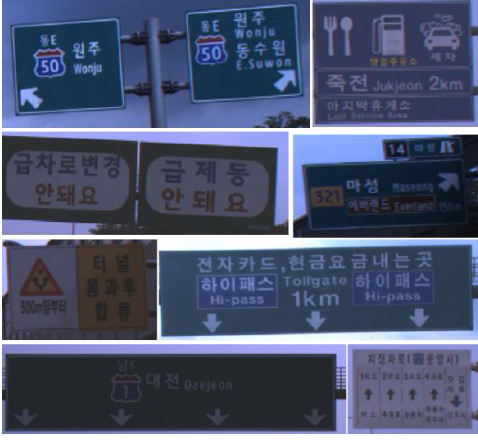
Figure 2. An image of a road sign whose background color is blue ( a ) and the color probability map of the image ( b ) [28].